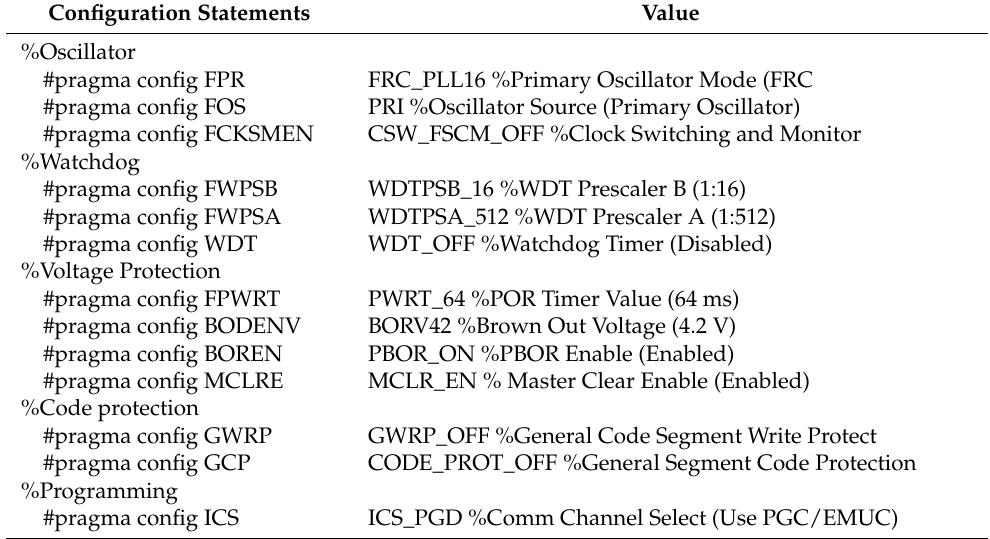
Table 5. Configuration statements of the DSP device.